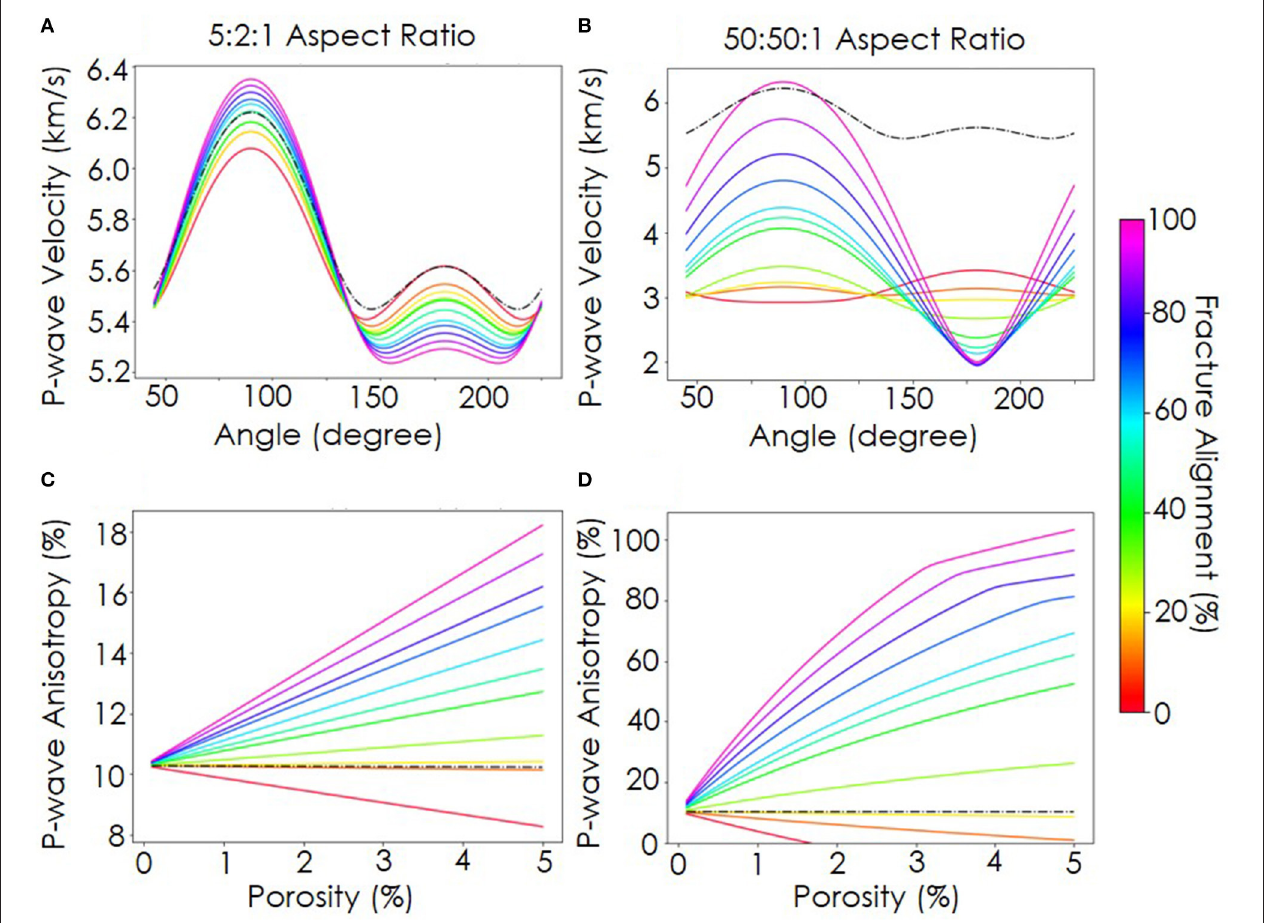
FIGURE 9 | P-wave velocity and anisotropy with angles of propagation to foliation for a 5% porosity protomylonite from GassDEM modeling. Two aspect ratios are compared: (A,C) 5:2:1 and (B,D) 50:50:1. The color represents fracture alignment to foliation, from all fractures being randomly oriented (0%) to perfectly aligned fractures to foliation (100%), and combinations of these. The black dashed lines are results for a rock with 100% spherical pores (1:1:1 aspect ratio) for